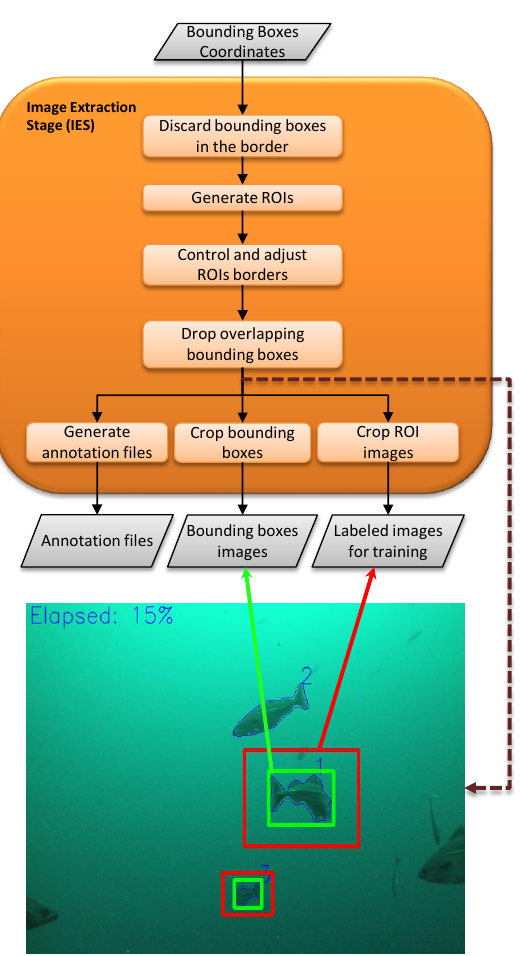
Figure 3: Flow diagram of the image extraction stage